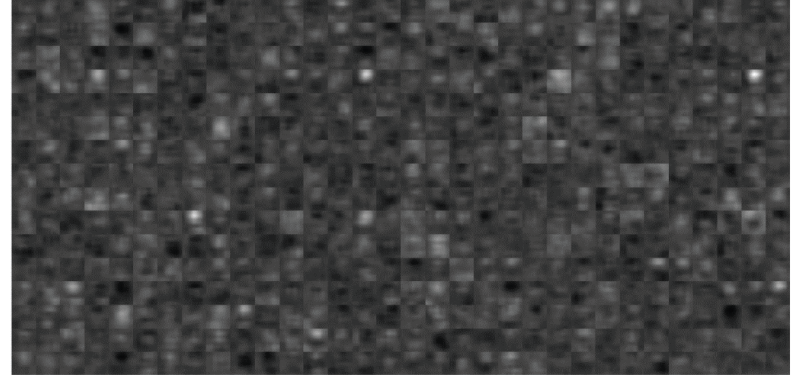
Figure 12: Feature images of